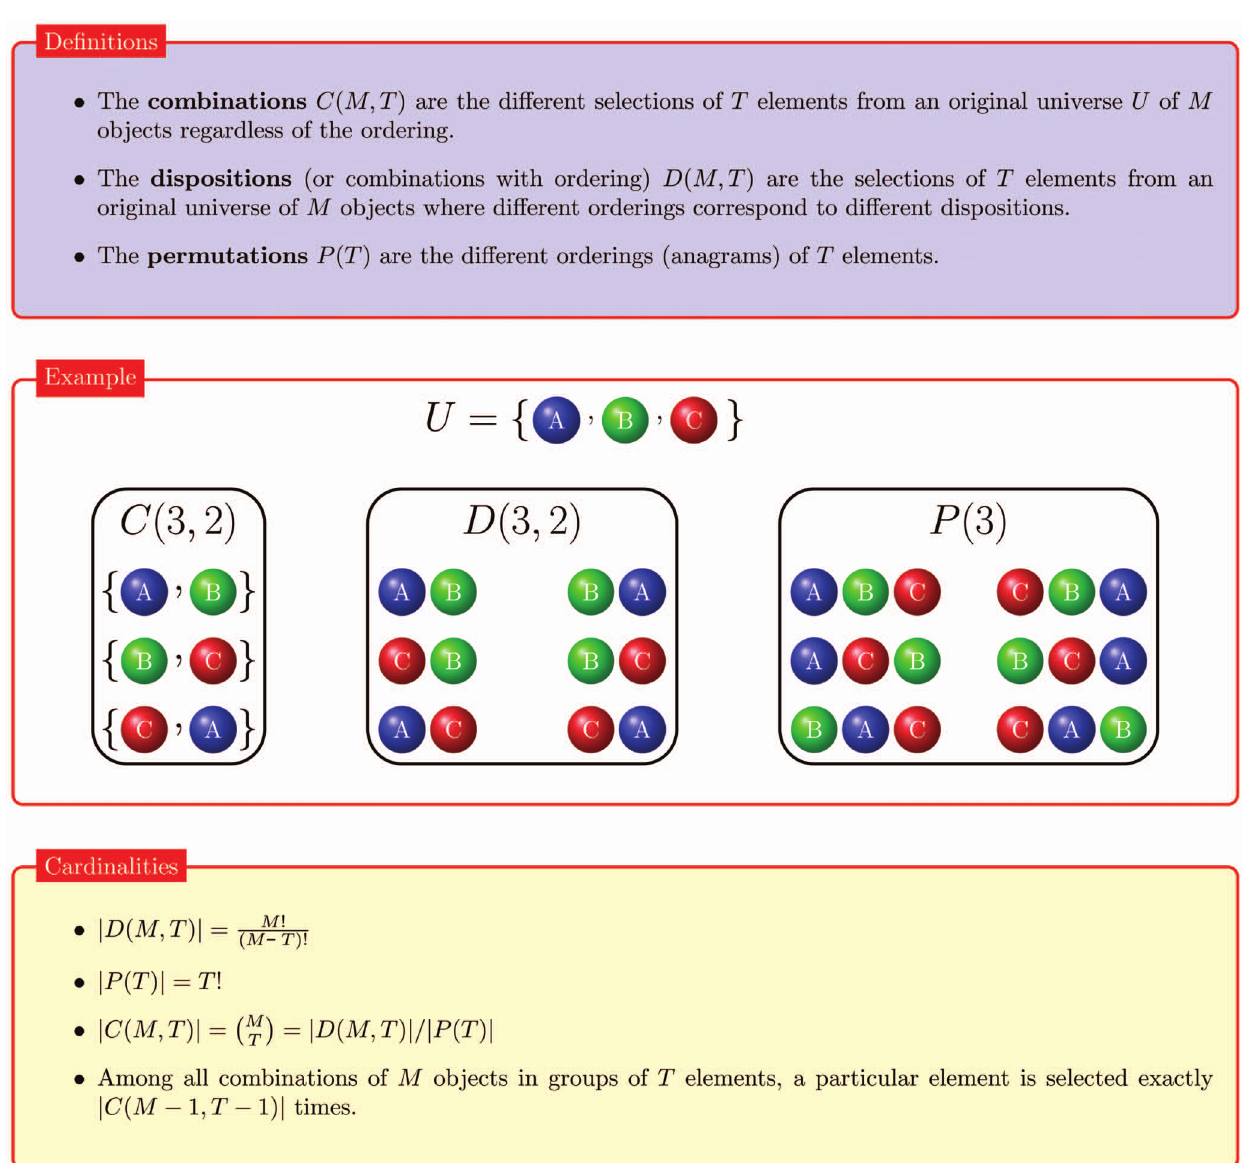
Figure 4. Basic definitions, examples and facts on dispositions, combinations and permutations.